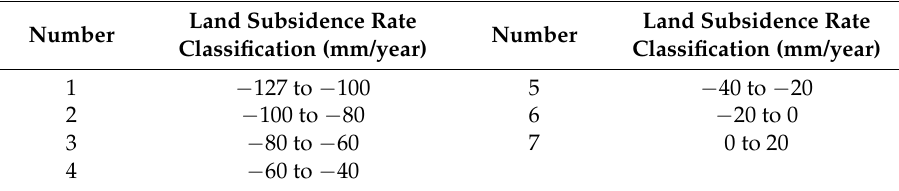
Table 3. Land subsidence rate classification. Minus signs represent subsidence.